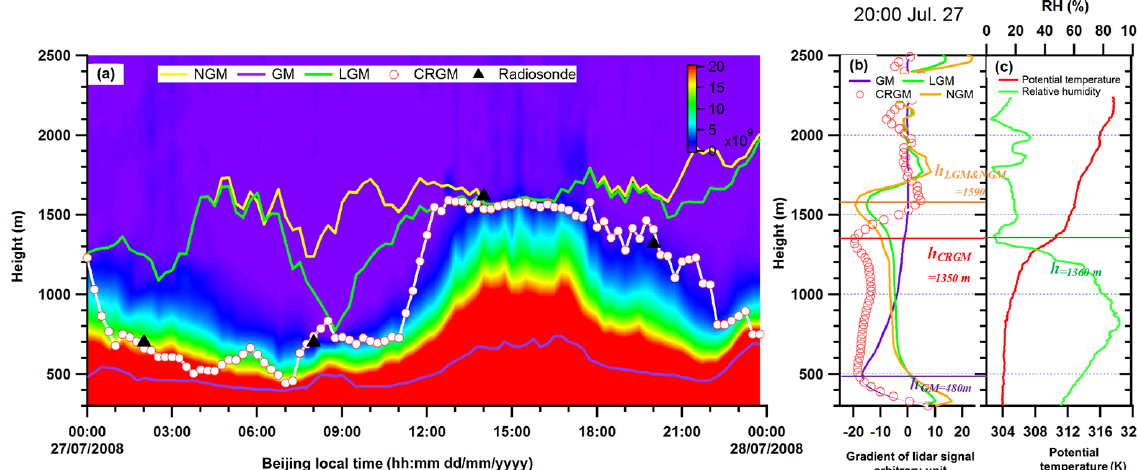
Figure 4. (a) Same as Fig. 2a but with the addition of the diurnal BLH retrieved by CRGM as a white line with red outline and white circles. (b) Same as Fig. 2b but with the addition of the CRGM profile as a red dotted line. (c) Same as Fig. 2c.